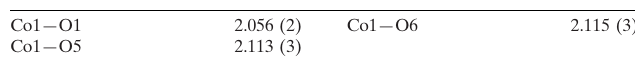
Selected bond lengths (A˚ ).